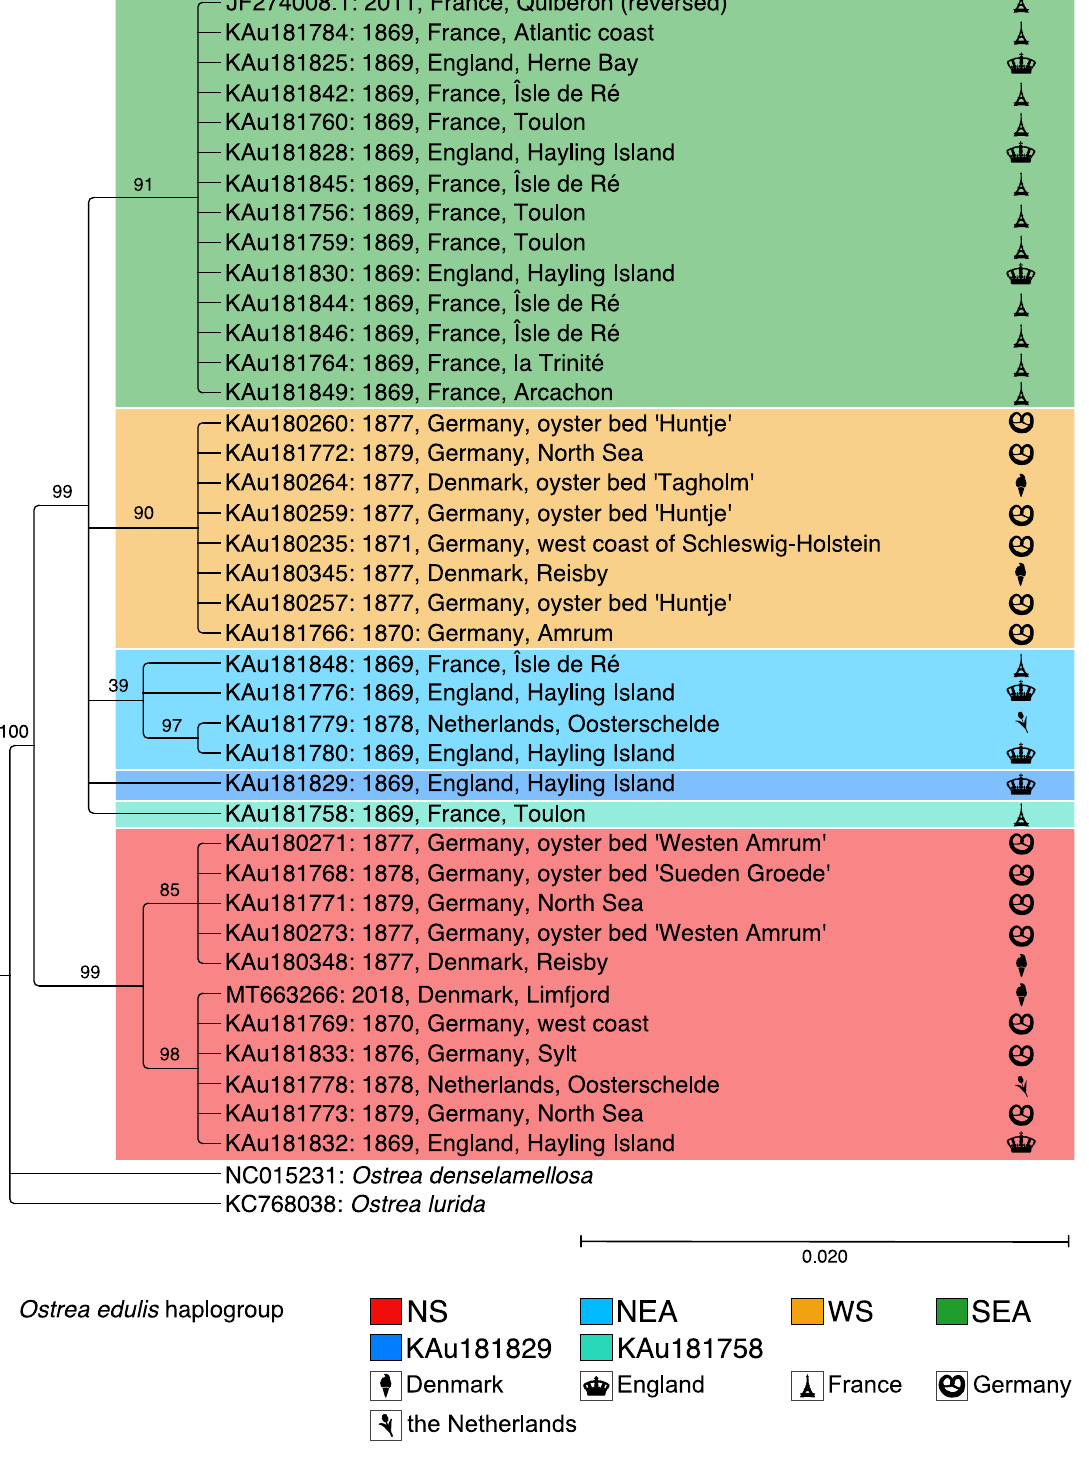
Figure 2. Phylogeny of ancient mitochondrial genomes mapped against MT663266 (complete mitochondrial genome generated in this study) and controlled with JF274008.1 (complete mitochondrial genome in GenBank) using the maximum likelihood method and General time Reversible model using all sites. Bootstrap node support (in percent, from 500 replicates) is shown next to the branches. All branches with less than 35 bootstrap support are collapsed. Colour shading highlights different haplogroups. Phylogeny is rooted with O. lurida and O. denselamellosa . This analysis involved 41 nucleotide sequences with a total of 16,653 positions in the final dataset. Legend: NS = North Sea, NEA = North East Atlantic, WS = Wadden Sea, SEA = South East